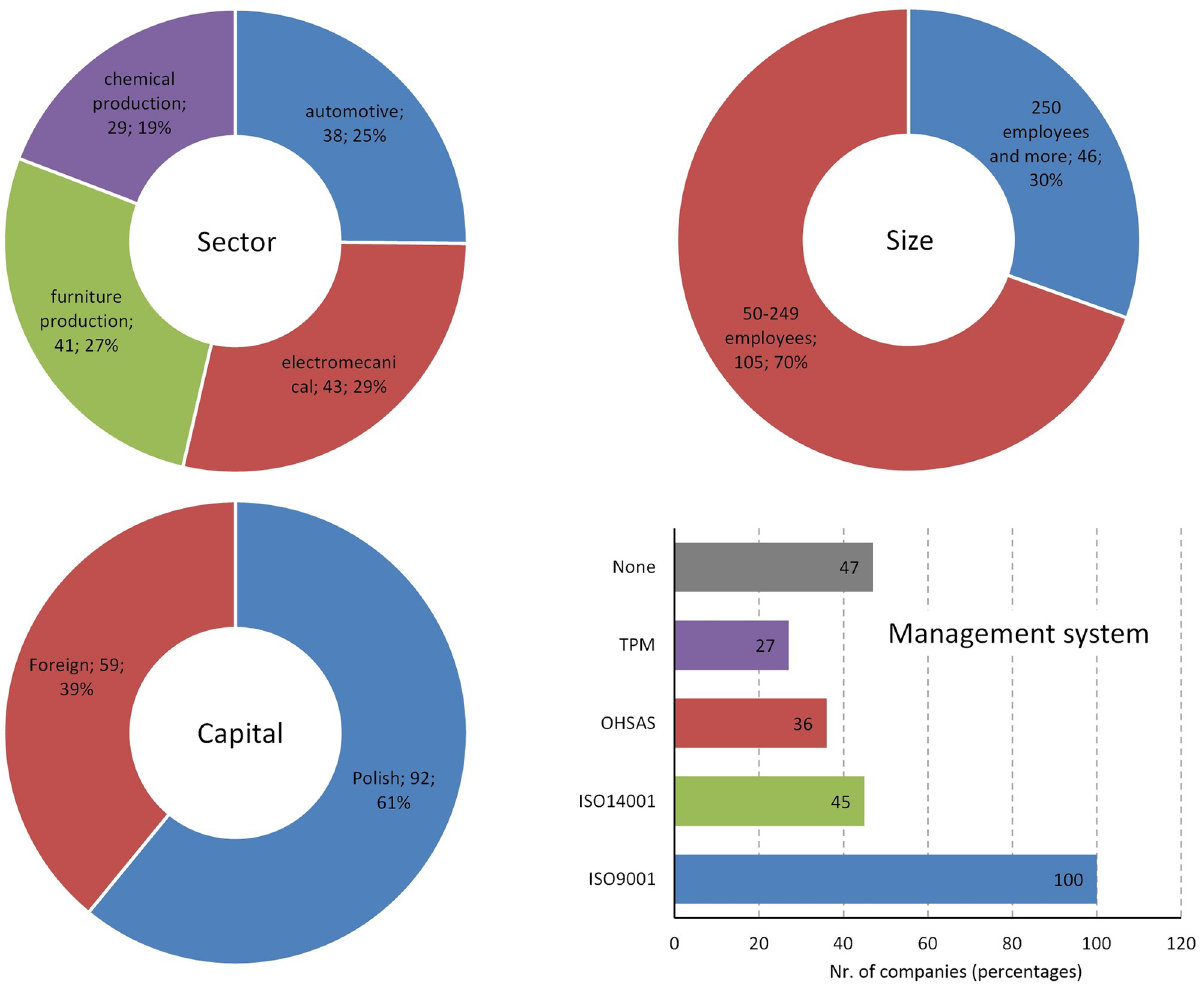
Fig 1. Basic characteristics of